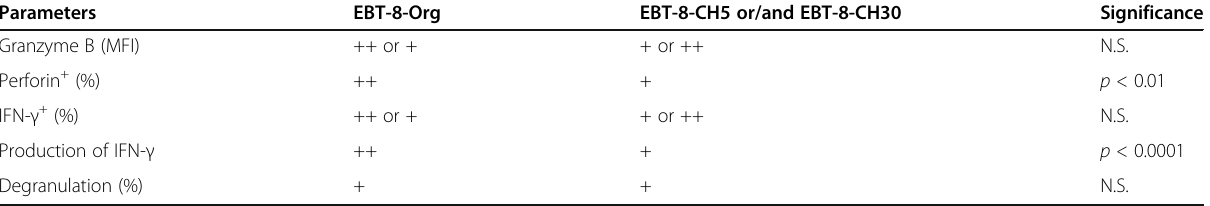
Table 3 Functional properties of human CD8 + T cell line following long-term exposure to asbestos fibers